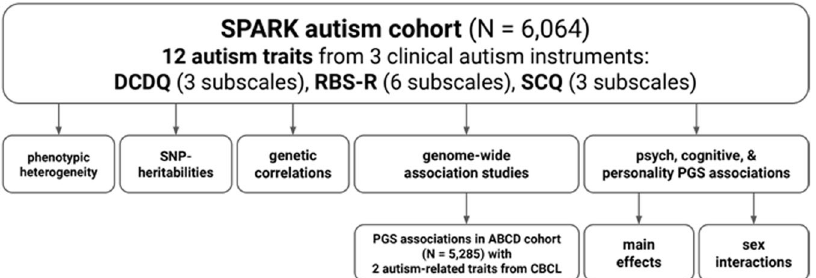
Fig. 1 Study overview. Twelve quantitative, clinical autism subscale traits were measured in N = 6064 autistic children in the SPARK cohort: three DCDQ subscales, six RBS-R subscales, and three SCQ subscales. These subscales were investigated both at the phenotype and genomic level, including SNP-heritabilities ( h 2 ), intra-cohort genetic correlations, genome-wide association studies (GWAS), and polygenic scores (PGS) associations with 14 psychiatric, cognitive, and personality traits. In addition, the GWAS were used to calculate PGS in a general population childhood cohort, ABCD ( N = 5285). These PGS were then compared to the autism case-control PGS in association with two autism-related quantitative behavior traits from the